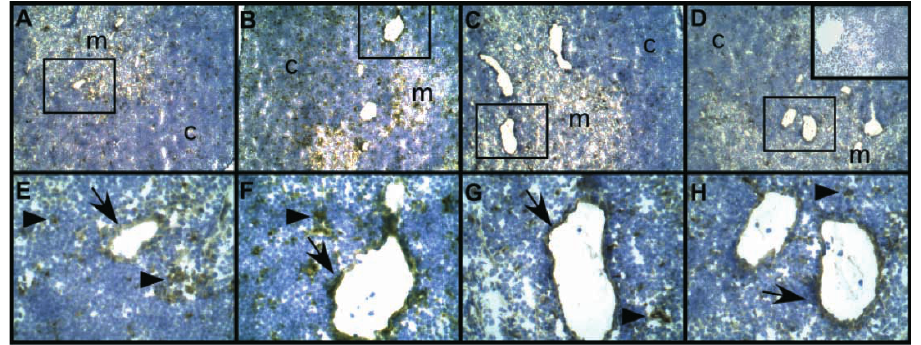
FIGURE 2 VCAM expression on thymic stromal cells and endothelial cells of postcapillary venules. VCAM expression was examined by immunohistochemistry on thymuses from animals at 4 weeks (A and D), 5 weeks (B and E), 7 weeks (C and F) and 9 weeks (D and H) of age. Regions defined on the low power images (A–D, 100 £ original magnification) are enlarged in panels E–F (400 £ original magnification). Positive staining was observed at a relatively higher level on blood vessels (arrows) than on stromal cells (arrowheads). Inset in panel D shows an isotype-matched antibody control. M ¼ medulla; C ¼ cortex.